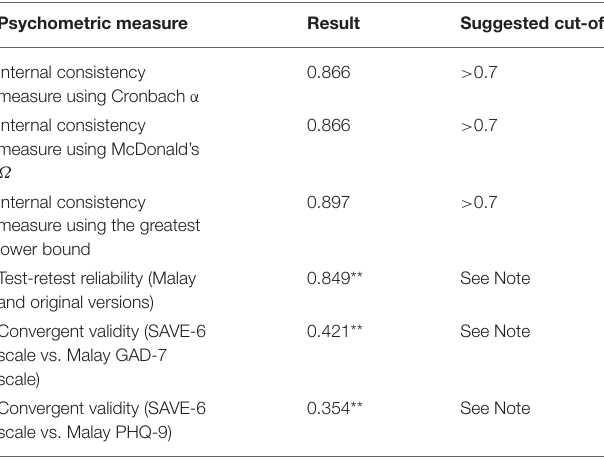
TABLE 3 | Psychometric properties of the Malay version of the SAVE-6 scale at the scale level ( n = 257). Psychometric measure